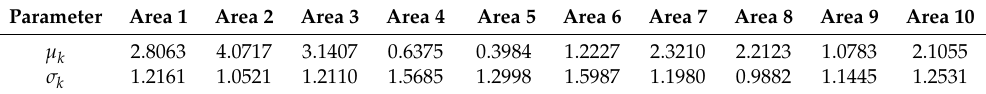
Table 13. Values of the parameters µ k and σ k estimated from the log data in Example 5, part I.